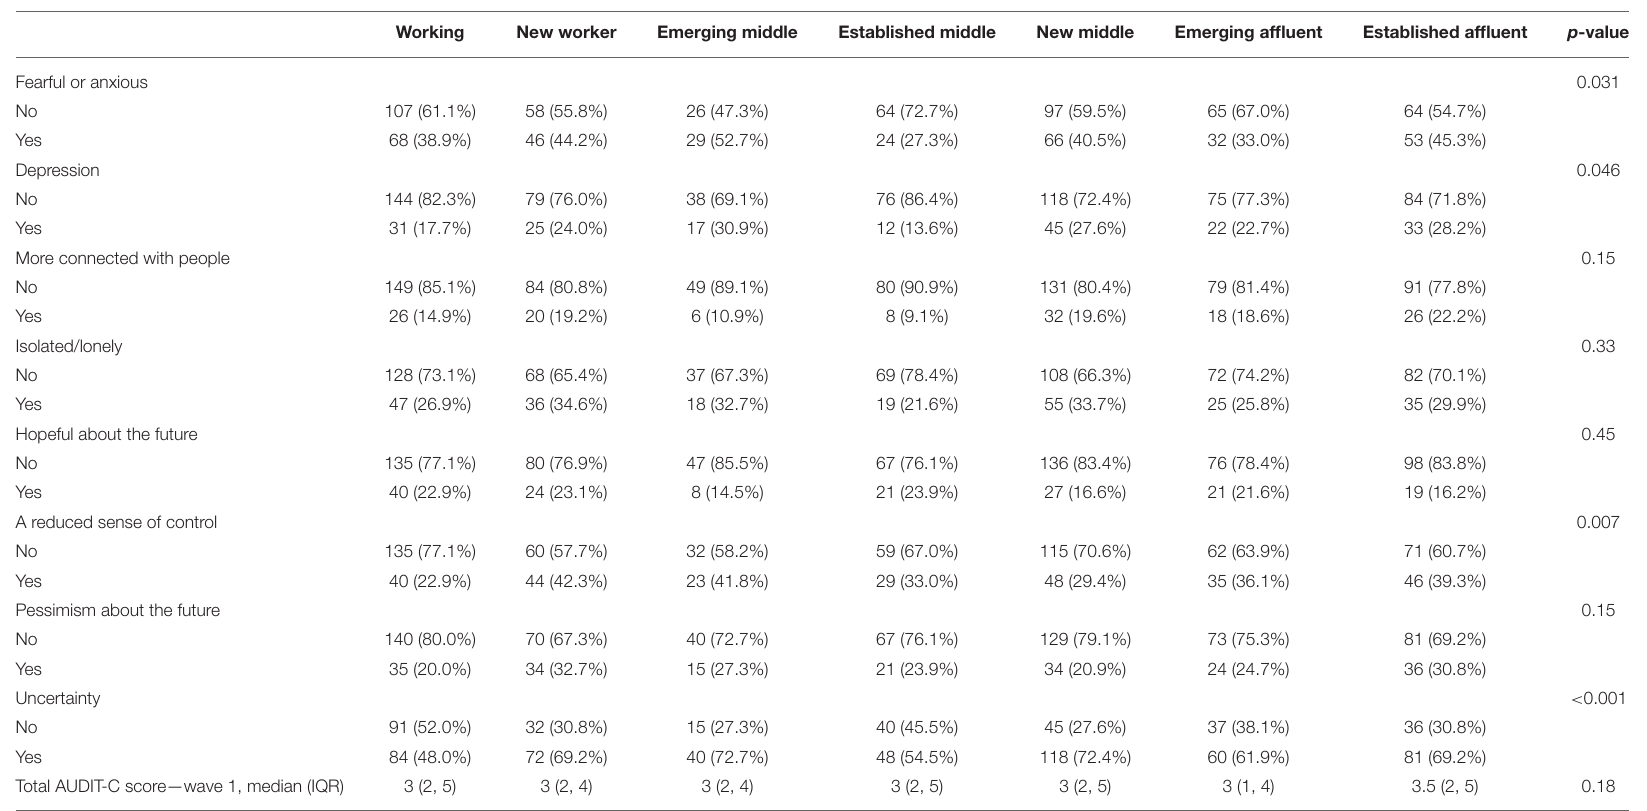
TABLE 4 | Affect and alcohol patterns at time point 1 by social class ( n = 799). Working New worker Emerging middle Established middle New middle Emerging affluent Established affluent p